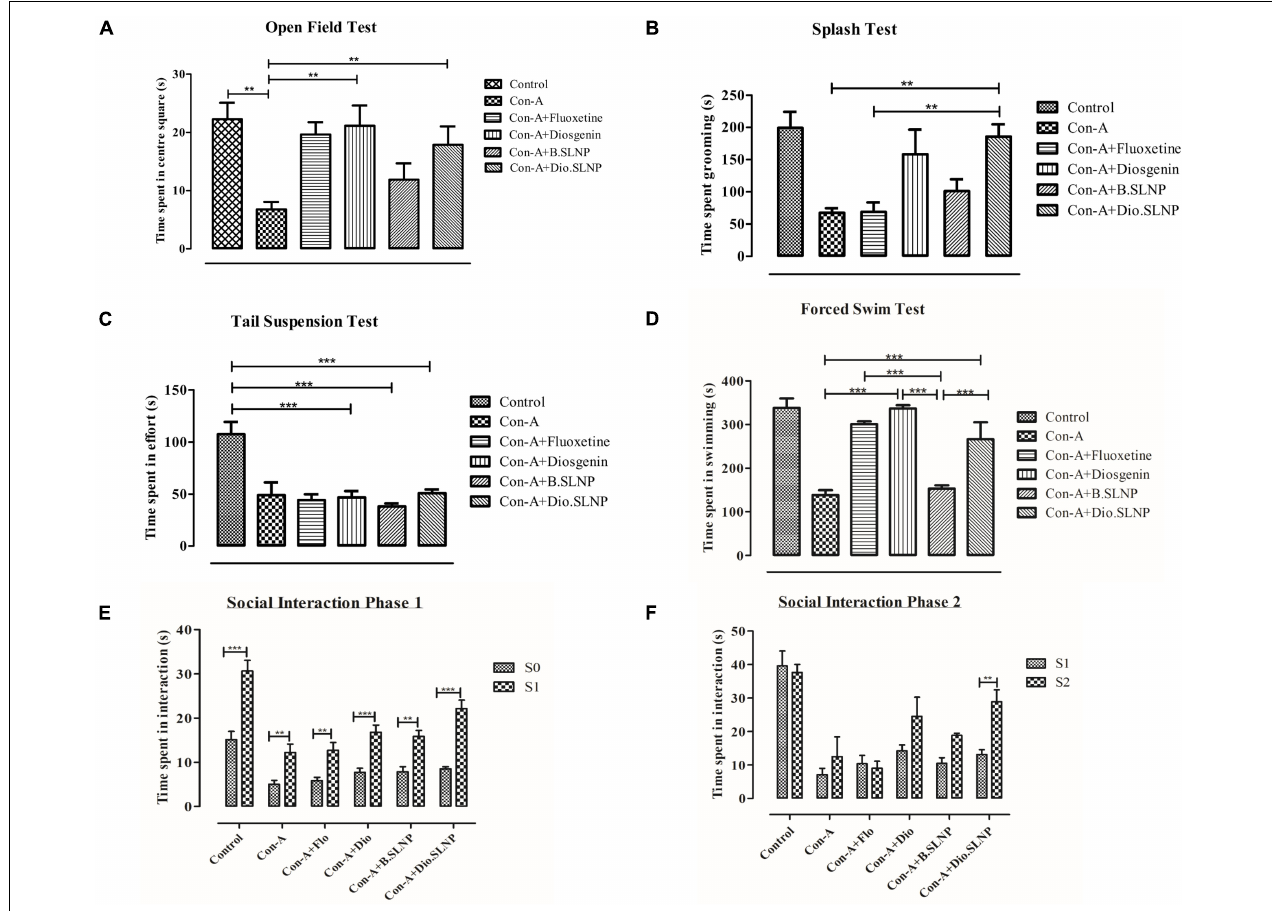
FIGURE 7 | Quantification and comparison of different treatment groups of mice. Control group was subjected to intraperitoneal injection of saline (10 ml/kg body weight), and all other groups were subjected to intraperitoneal injection of Con-A (10 mg/kg prepared) and 30 min later were treated with intraperitoneal injection of fluoxetine (20 mg/kg body weight), diosgenin (100 mg/kg in body weight), blank solid lipid nanoparticles, and diosgenin solid lipid nanoparticles. (A) Graph of open field test showing comparison of total exploratory time (seconds) spent in the center square of box after 24 h of exposure with Con-A. Con-A–treated group showed decreased locomotory exploration when compared with other groups. Significant increase in locomotory behavior was observed in Con-A+Diosgenin ( p < 0.01) and Con-A+Diosgenin solid lipid nanoparticles ( p < 0.01). (B) Sucrose splash test. A significant difference was observed between Con-A vs. Con-A+Diosgenin solid lipid nanoparticles ( p < 0.01) and Con-A+Flo vs. Con-A+Diosgenin solid lipid nanoparticles ( p < 0.01). (C) Tail suspension test. Con-A group showed decreased mobility as compared with control group, which was not significantly increased in other groups. (D) Forced swim test. Con-A group exhibited decreased mobility while significant increase in mobility time is observed in other groups treated with fluoxetine, diosgenin, and diosgenin SLNP; Con-A vs. Con-A+Diosgenin ( p < 0.001) and Con-A vs. Con-A+Diosgenin solid lipid nanoparticles ( p < 0.001). (E,F) Social interaction test showing phase 1 and phase 2, depicting social interaction and preference respectively. Phase 1 shows measurement of social preference between empty cage (S0) and caged mice (S1) by treated mice in which every group showed significant difference to that of Con-A group, and phase 2 shows social novelty between known caged mice (S1) and new caged mice (S2) by different groups of treated mice in which significant difference is observed between Con-A vs. Con-A+Diosgenin solid lipid nanoparticles ( p < 0.01). Error bars represent mean ± SEM for one-way and two-way ANOVA followed by Bonferroni’s multiple comparison analysis. Significant values: ** p < 0.01, *** p <